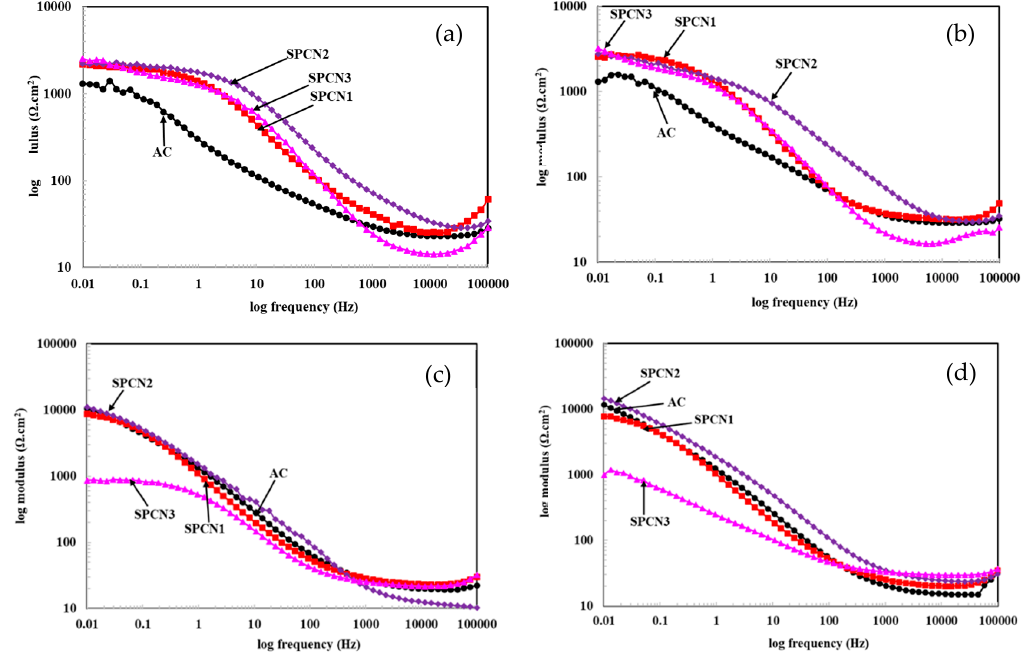
Figure 5. Modulus-frequency Bode plots of coatings after ( a ) 1 h, ( b ) 11 days, ( c ) 41 days, and ( d ) 89 days of exposure in 3.5 wt.% NaCl solution.